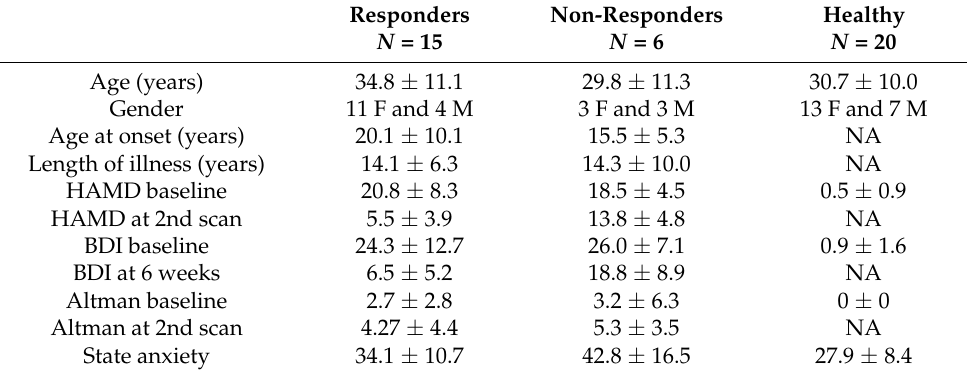
Table 1. Demographics and clinical scores (for patients for whom both valid baseline and follow- up resting state data were available), presented as a mean ± standard deviation (SD). Treatment responders (R) and non-responders (NR) differed significantly at the second scan assessment in HAMD score ( t = − 4.140, p = 0.001) and BDI score ( t = − 3.994, p = 0.001). All other differences between R and NR, as well as R, NR and healthy controls (HC), were not significant ( p > 0.05). Responders Non-Responders Healthy N = 15 N = 6 N =